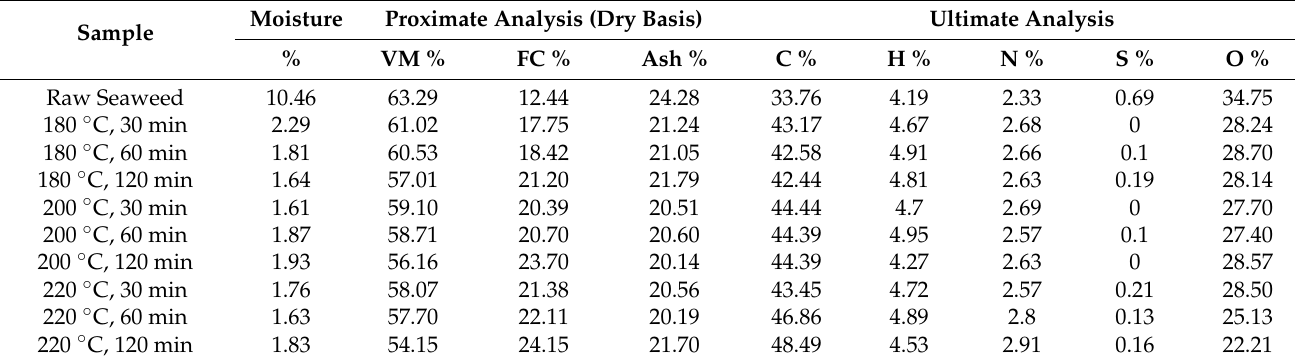
Table 3. Proximate and ultimate analysis of the raw seaweed and the hydrochar